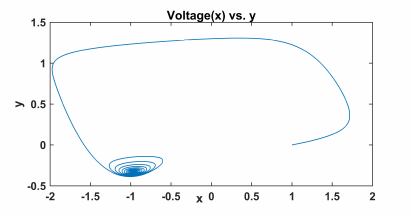
Figure 8. Recovery variable (right) with a constant external current value, I(t) = 1 µ A / cm 2 , a = 0.8 , b = 0.7 & c = 3